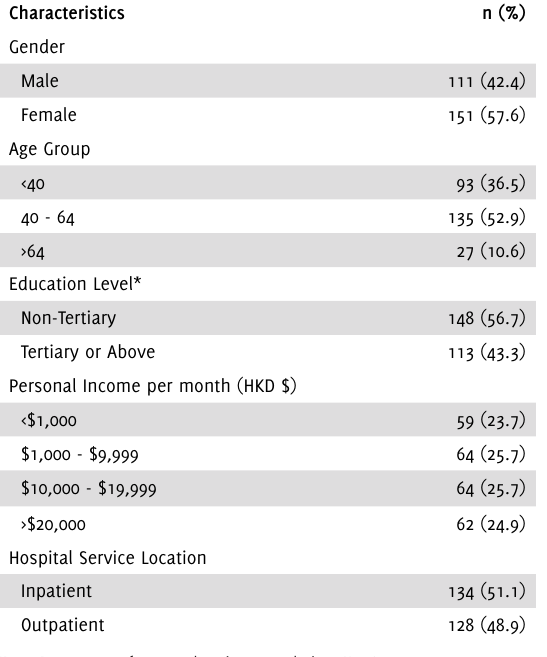
Table 1. Patient Socio-Demographic Characteristics and Hospital Service Lo- cation when Surveyed